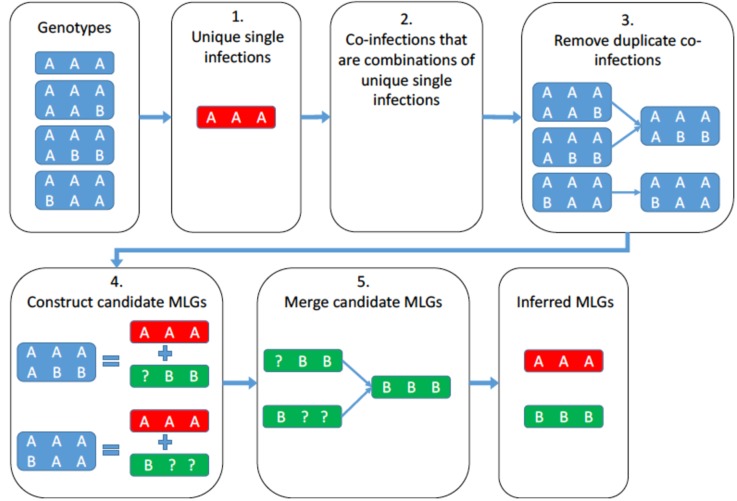
A schematic representation of the algorithm that identifies the unique multilocus genotypes that form the observed coinfections.